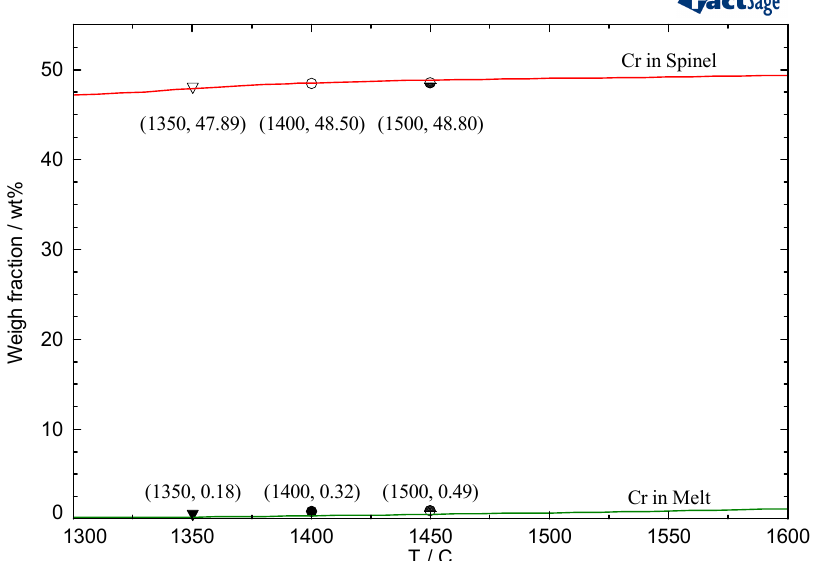
Figure 8. Content of chromium in the spinel crystal and liquid phase during slag solidification.